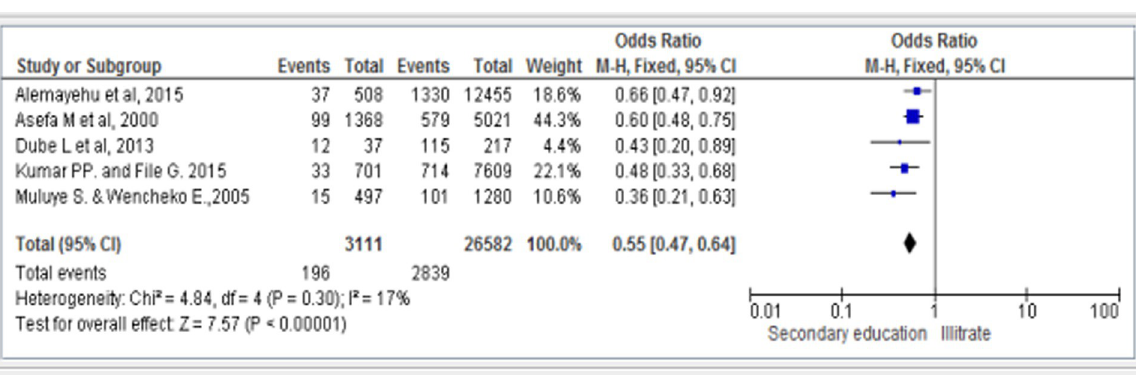
PLOS ONE | https://doi.org/10.1371/journal.pone.0220076 July 29,